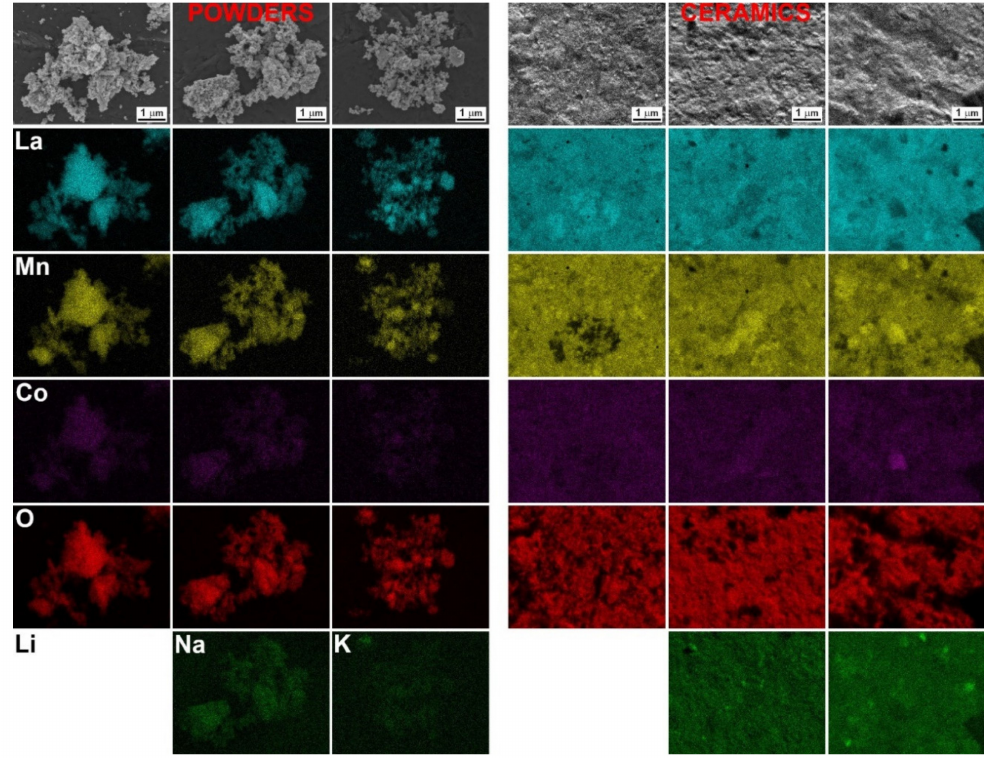
Figure 3. Energy dispersive spectroscopy (EDS) maps of La 0.9 A 0.1 Mn 0.9 Co 0.1 O 3 powders ( left ) and ceramics ( right